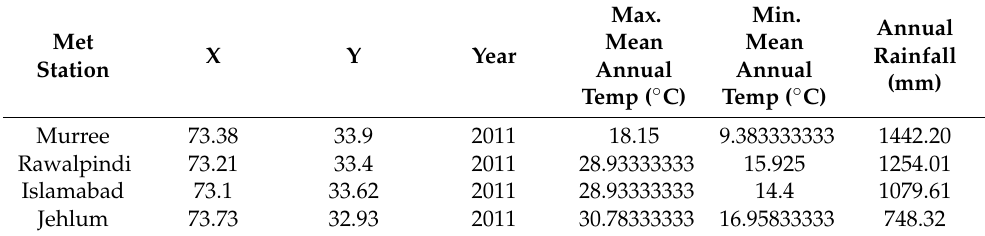
Table 7. Climatic data of four Met. Station for the year 2011.